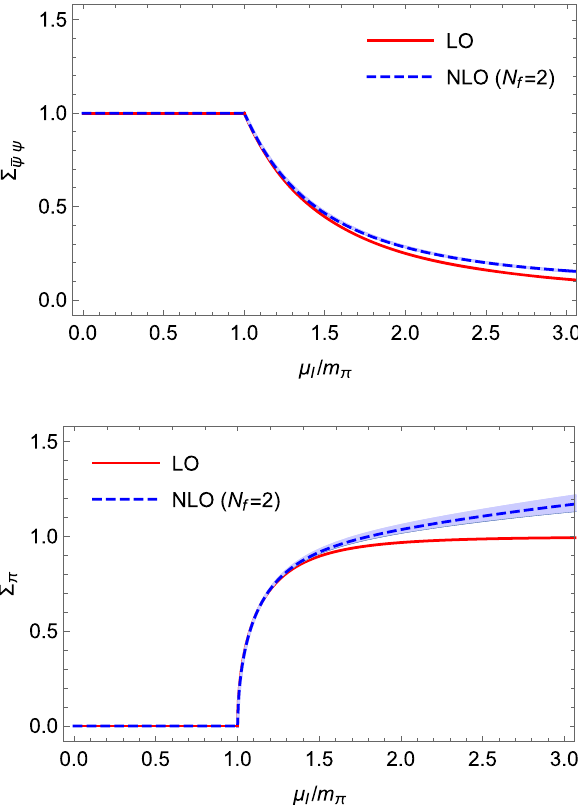
Fig. 2 Top: Quark condensate deviation (normalized to 1) from the normal vacuum value, Σ ¯ ψψ , at T = 0. Bottom: Pion condensate devi- ation from the normal vacuum value (which is 0), Σ π , at T = 0 and j = 0. See text in Section 5.3 for